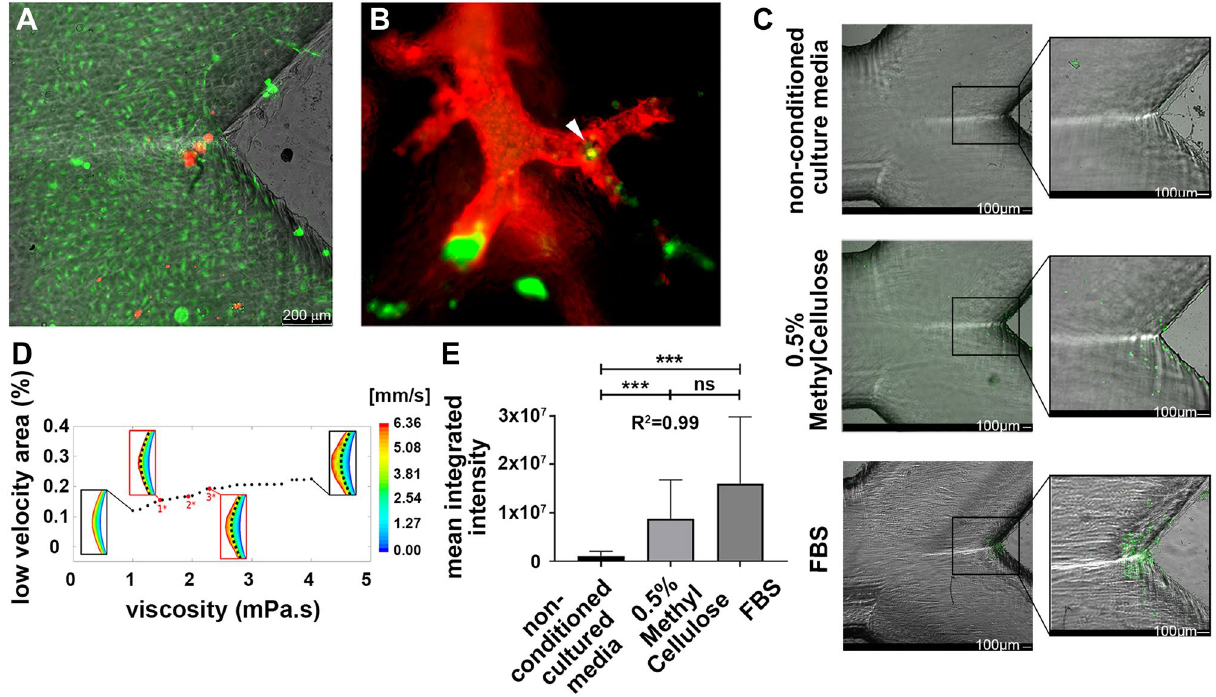
Figure 3. ( A ) DiD-labelled MDA-MB-231 cell (red CTC) arrest at the bifurcation of the Y-microchannel covered with calcein-labelled primary HUVEC cells (green endothelial monolayer). ( B ) Representative image of GFP-labelled MDA-MB-231 cells (green CTC) perfused in mice before direct labelling of the vasculature of the lung with DiI dye (red blood vessels), illustrating the CTC arrest at the carina of vessel bifurcations (arrowhead) in an in vivo preclinical model. The size bar in panel A is valid also for panel B. ( C ) GFP-labelled MDA-MB-231 cells embedded in three different types of fluids: non-conditioned basal culture media (upper panels), 0.5% Methylcellulose (middle panels), and FBS (foetal bovine serum; lower panels), showing improved CTC arrest at the low-velocity areas of the carina as the viscosity of the medium is increased. ( D ) Numerical representation of the low-velocity areas at the carina of the bifurcations depending on the viscosity of the medium, as calculated in the simulations. The insets correspond to the graphical representation of the areas of low velocity at different viscosity values illustrating the enlarged area as the viscosity is increased (the dashed black line marks the boundary for the lowest viscosity). The viscosity of the three different media included in panel ( C ) were numerically checked and their values (1*, non-conditioned culture medium; 2*, FBS (foetal bovine serum); and 3*, 0.5% Methylcellulose) and corresponding graphical low-velocity areas are plotted in red. ( E ) Quantification of CTC arrest calculated by integrated intensity, is graphically described. Statistical differences were found between the groups, seeing higher levels of CTC arrest with higher viscosity levels ( t -test, *** p < 0.001; R 2 =